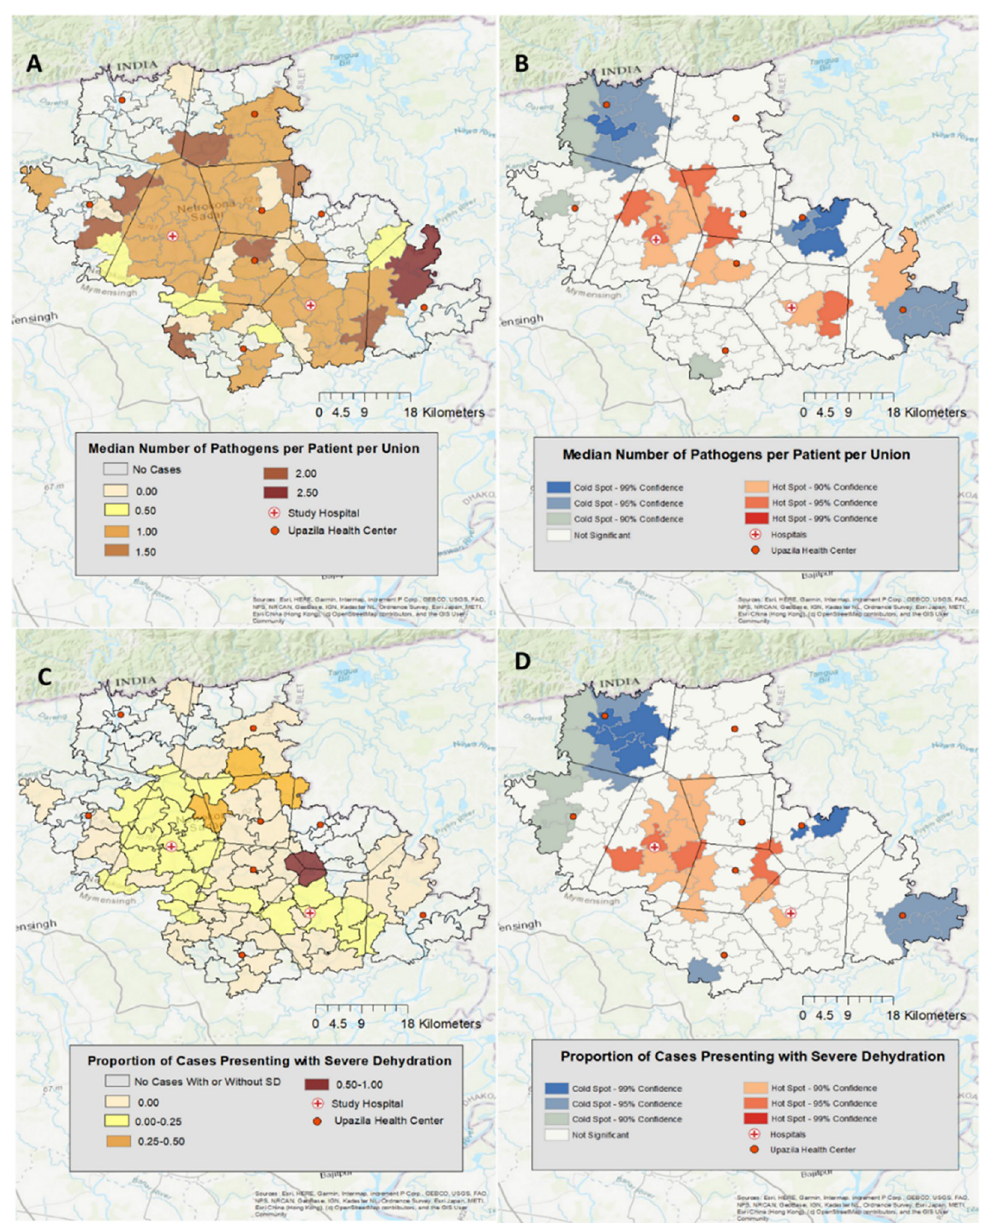
Fig 5. Geospatial distribution of diarrheal disease. A. Median number of pathogens per patient per administrative unit (union). B. Hotspot Analysis: Median number of pathogens per patient per union hot and cold spots. C. Proportion of cases presenting with severe dehydration per administrative unit (union) among subset of patients enrolled after November.15 th . Data are derived from patients in which a stool sample was collected. D. Hotspot Analysis: Proportion of cases presenting with severe dehydration per union ‘hot’ and ‘cold’ spots. Basemap: World Topographic Map [29]. pathogens detected and severe dehydration (S2 Table). There was no significant difference in the odds ratio of severe dehydration between patients infected with V . cholerae compared to patients without an etiologic pathogen detected (OR = 1.43, CI: 0.48–3.70); similar findings were observed for the other enteropathogens (S3 Table). We analyzed the data for geospatial correlates of severe dehydration. The proportion of cases presenting with severe dehydration